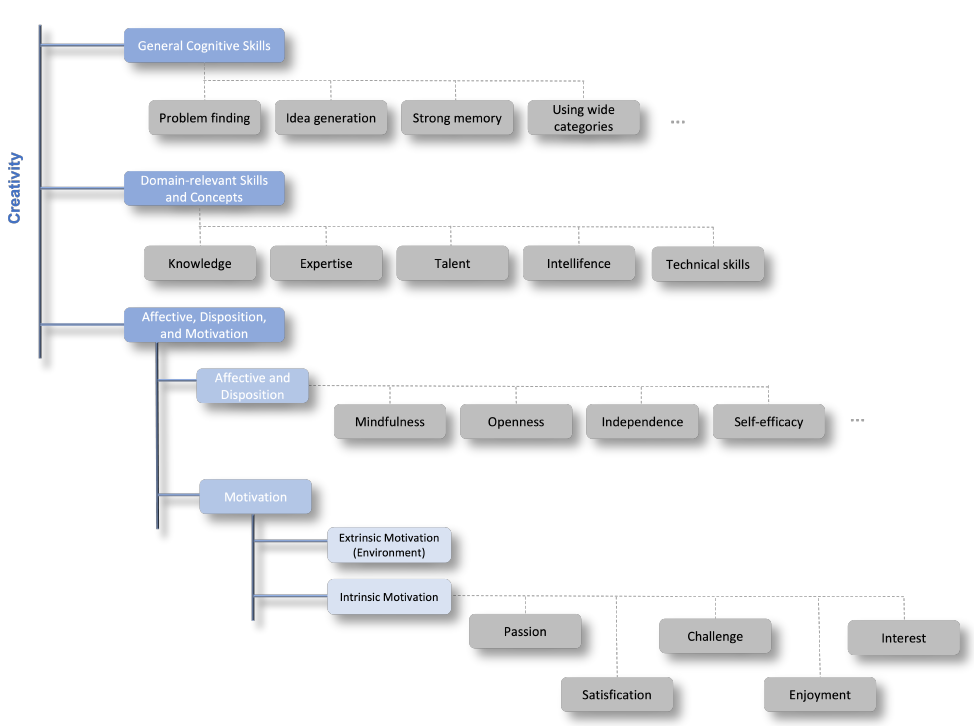
Figure 3. A fragment of the Educational Knowledge Base focusing on creativity